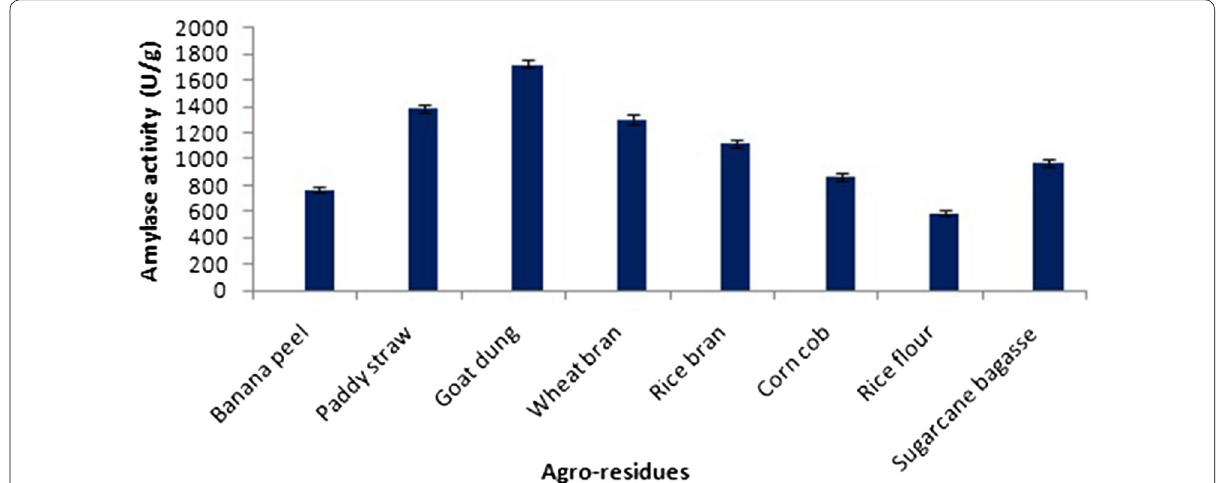
Fig. 1 Amylase activity of strain ALA4 in the presence of various agro-residues. Values represent mean